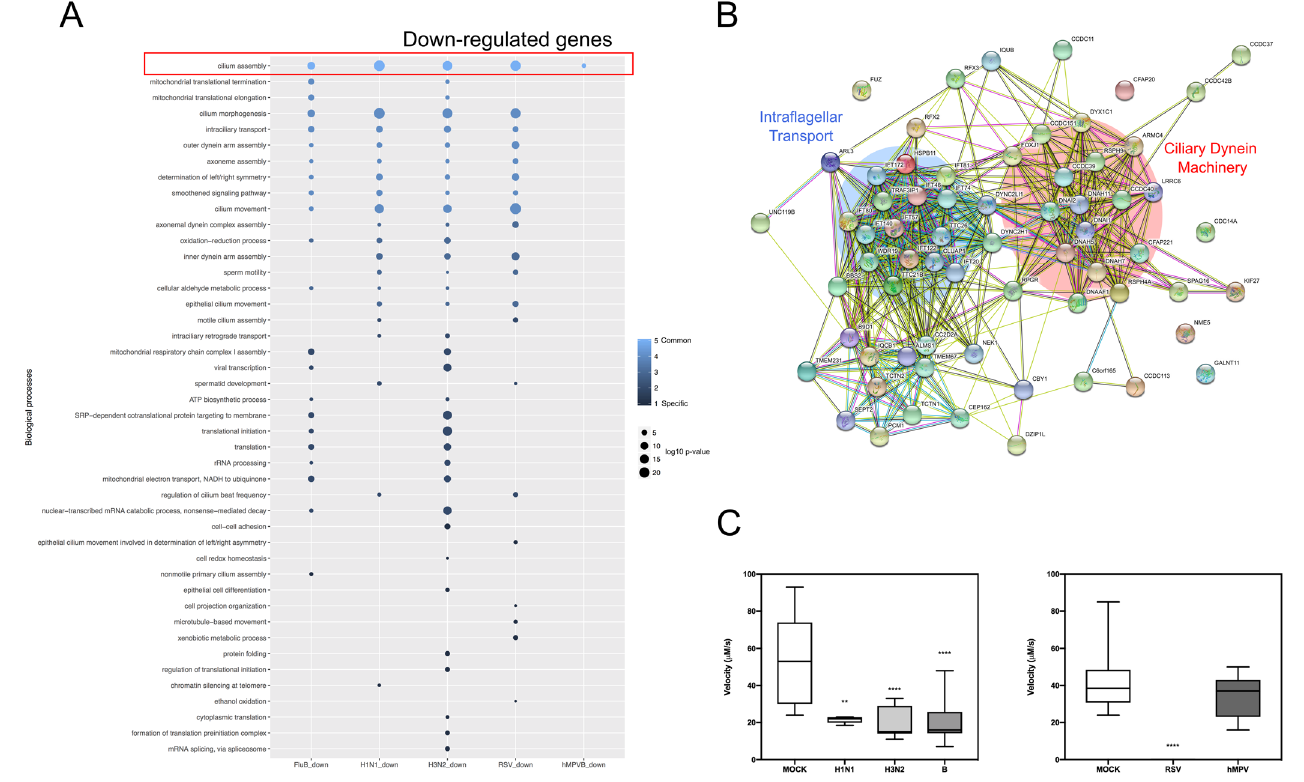
Figure 6. Cilium assembly/morphogenesis is down-regulated in viral-infected HAE. The significant enriched biological processes (down-regulated genes) induced by viral infections and their associated Benjamini- corrected p-values are shown (panel A). The log10-transformed (Benjamini corrected enrichment p-value) is color-coded in a gradient from dark blue (specific to one infection) to pale blue (common between all five infections). Dot size is proportional to p-value. The absence of dot in a column signifies the absence of enrichment of this specific biological process with the defined thresholds. The cilium assembly is common between all infections. A functional network constructed with the STRING database was used to better visualize genes commonly modulated during infections ( panel B). The two resulting hubs account for proteins related to ciliary dynein machinery and intraflagellar transport. Finally, for an extra-validation of the impact of viral infection on mucociliary clearance, the velocity (panel C) of polystyrene beads was measured at the surface of infected HAE, in the same experimental conditions (MOI, timing) for H1N1, H3N2 and B (left panel), or hRSV hMPV (right panel) and compared to the velocity of identical beads in mock-infected HAE. ** p < 0.01